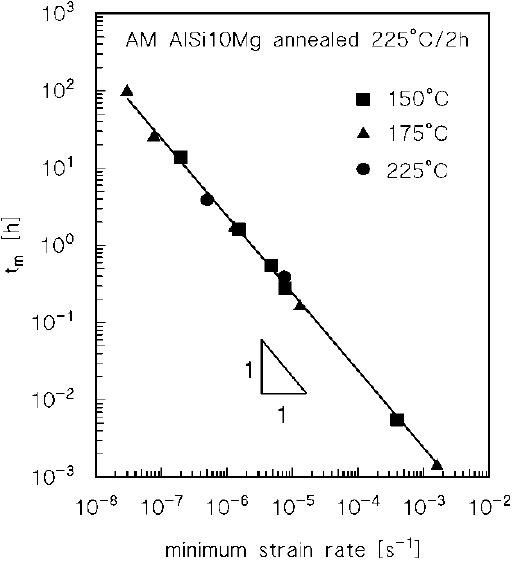
Figure 5. Time to minimum creep rate as a function of minimum creep rate for the annealed